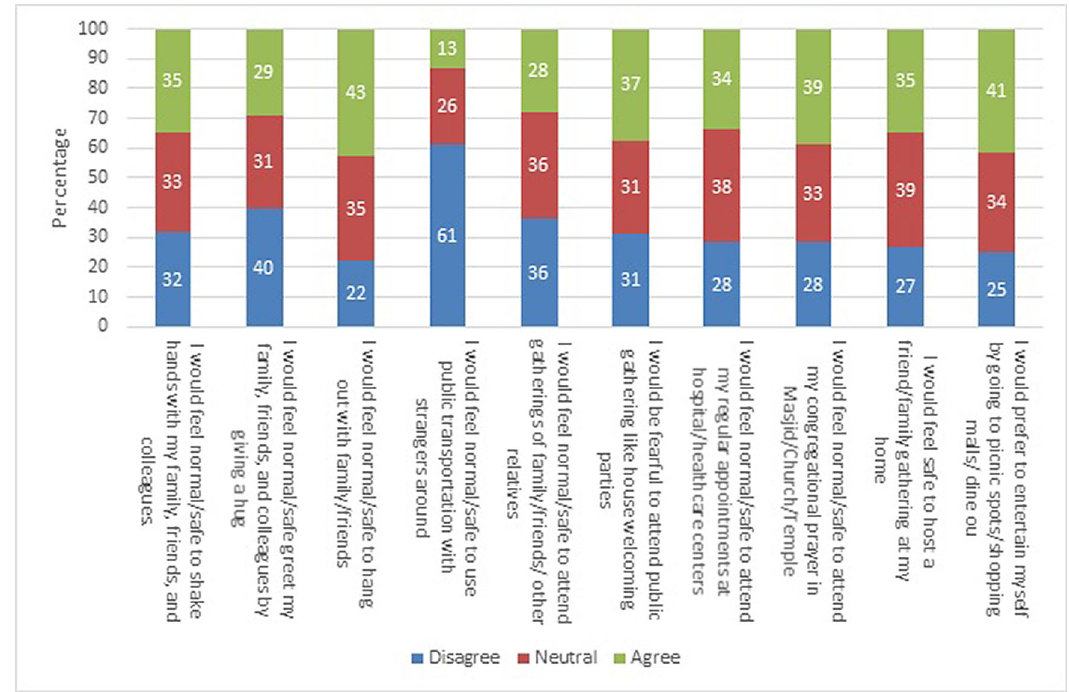
Figure 1. Participant perspectives regarding post-coronavirus disease 2019 (COVID-19) physical distancing behavior.